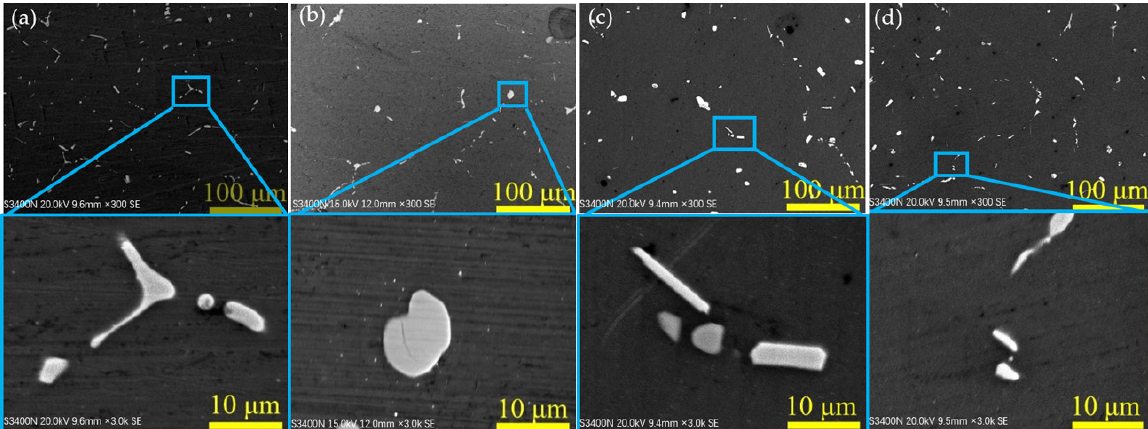
Figure 8. Microstructure evolution process of Al-5Zn-0.03In-1Er alloy by treatment at 615 °C for different times: ( a )16 h, ( b ) 24 h, ( c ) 32 h, ( d ) 40 h.